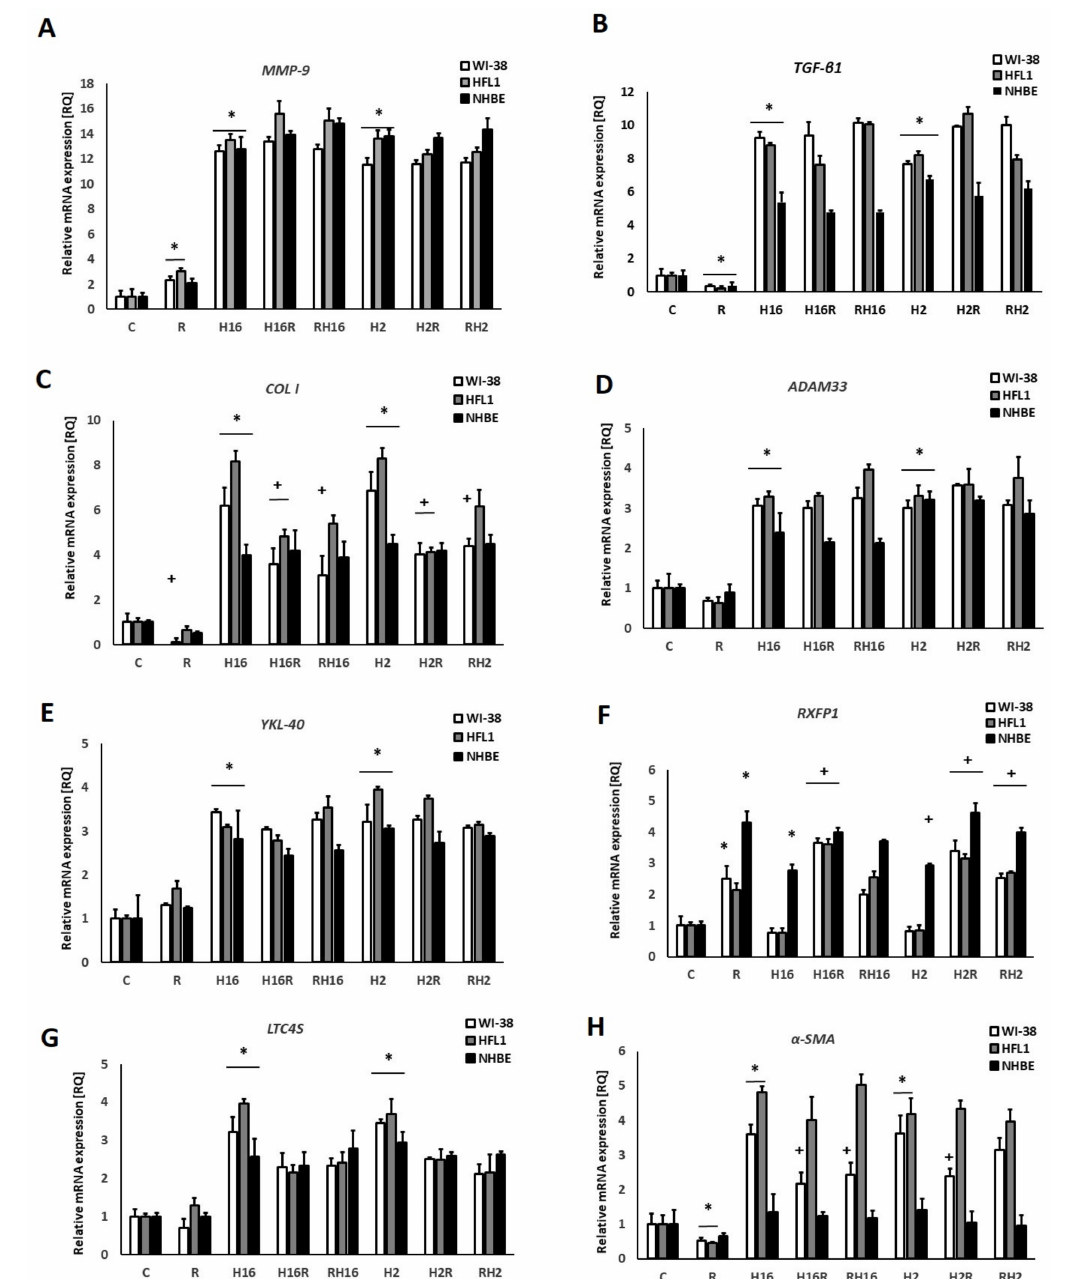
Figure 1. qPCR analysis showing the effect of relaxin (R) on airway remodeling-involved genes. Human Rhinovirus (HRV-2 or HRV-16) induced the expression of all genes analyzed, except for the RXFP1 (Relaxin Family Peptide Receptor 1) gene. Relaxin induced mRNA expression of MMP-9 (matrix metalloproteinase-9, ( A )), but reduced the expression of TGF- β (Transforming growth factor, ( B )) and collagen I ( C ). It also induced mRNA expression of RXFP1 (Relaxin Family Peptide Receptor 1, ( F )); no effect of relaxin was observed in ADAM33 (ADAM Metallopeptidase Domain 33), YKL-40 (Chitinase-3-like protein 1), and LTC4S (leukotriene C4 synthase) mRNA expression ( D , E , G ). Finally, relaxin inhibited HRV-induced expressions of collagen I ( C ) and α -SMA ( α -smooth muscle actin, ( H ). There were also no differences between the specimens when relaxin was added to HRV-infected cells or prior to the HRV infection: H16R, H2R—rhinovirus 16 and 2 added first, followed by relaxin—after 24 h, as well as RH16, RH2—relaxin added first, followed by rhinovirus-16 and 2—added after 24 h. * p < 0.05, in comparison to the control sample, and + p < 0.05 in comparison to the rhinovirus sample (HRV-2 or HRV-16, respectively); C is the control sample with medium only. N = 6, error